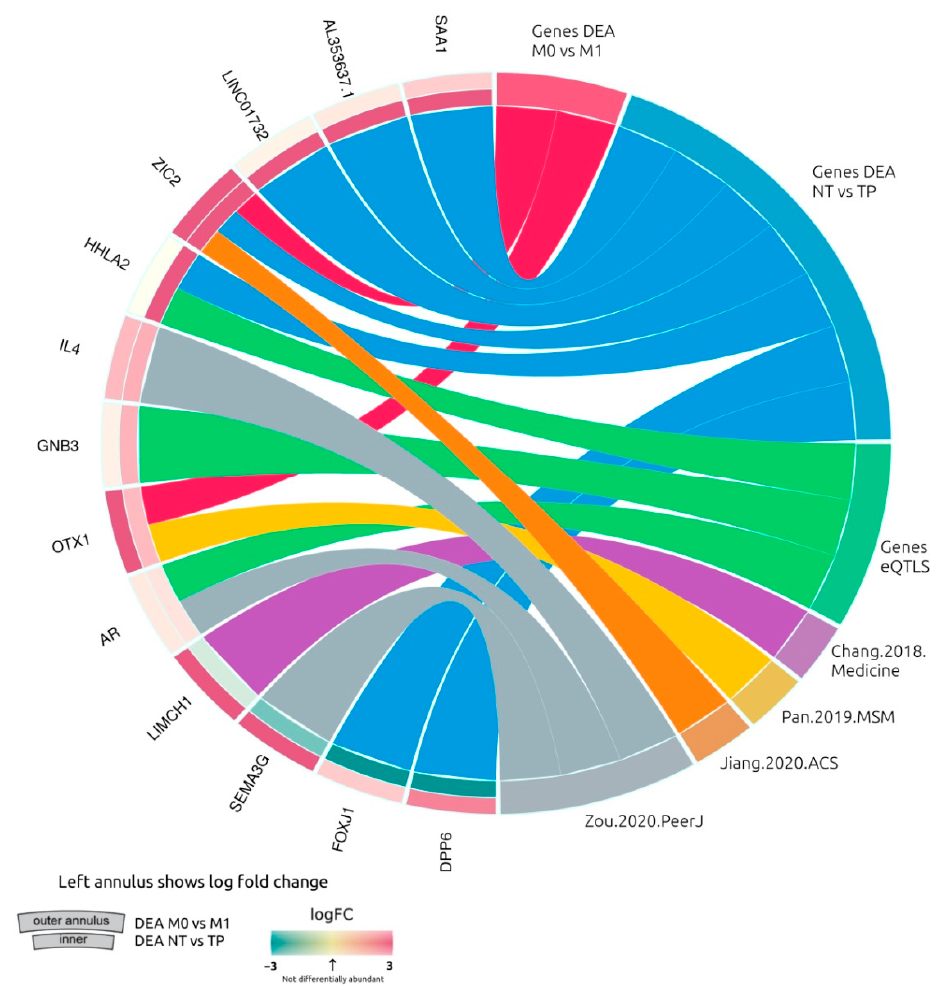
Figure A7. Circular diagram of mRMR gene signature and the source of genes DEA, genes from GTEx portal of expression quantitative trait loci (eQTLs) in Kidney Cortex, and gene signatures from the literature.